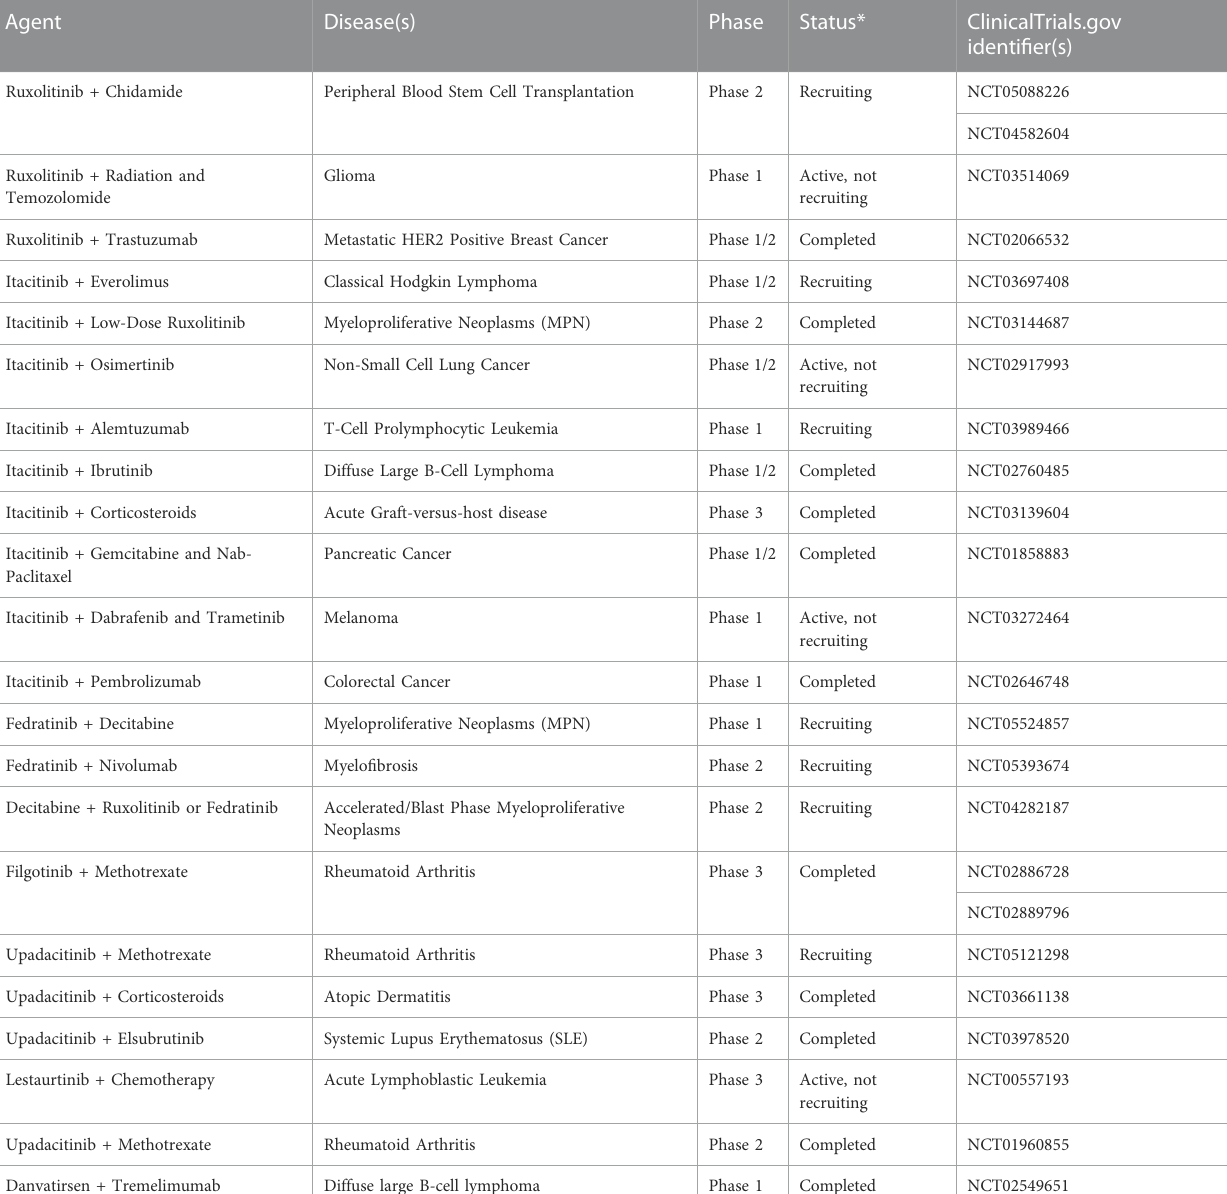
TABLE 3 JAK/STAT inhibitors are used in combination with other drugs.